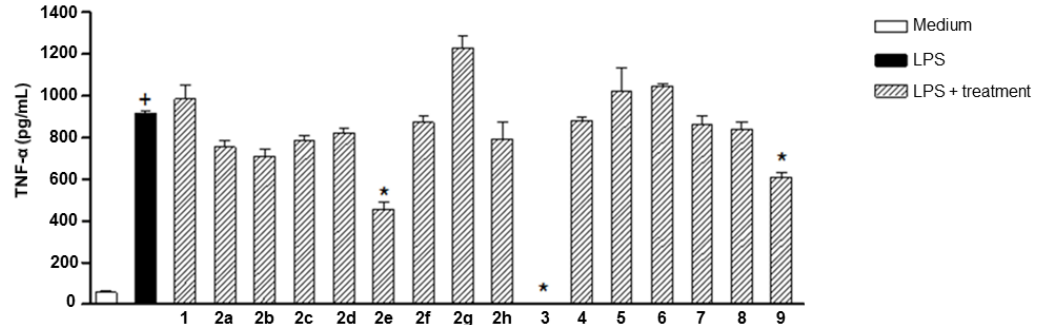
Figure 1. Effect of phenyl sulfonamide derivatives ( 1 , 2a – h , 3 – 8 ) and standard thalidomide ( 9 ) on TNF- α production from peritoneal murine macrophages stimulated with LPS in vitro (0.1 µg/mL). Screening concentration of 100 μ M was used. Values are mean ± SEM. + p < 0.05 compared with the group stimulated with medium; * p < 0.05 compared with the group stimulated with LPS; ANOVA followed by Newman-Keuls Student